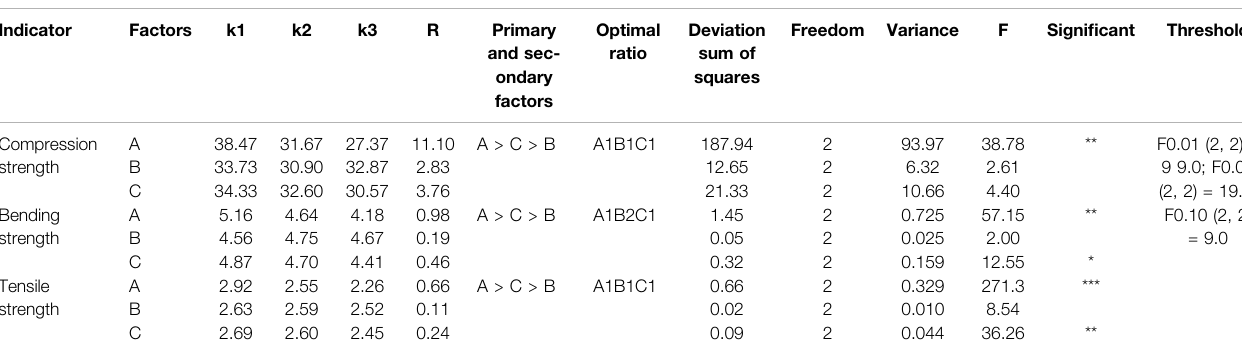
TABLE 7 | Range and variance analysis results.